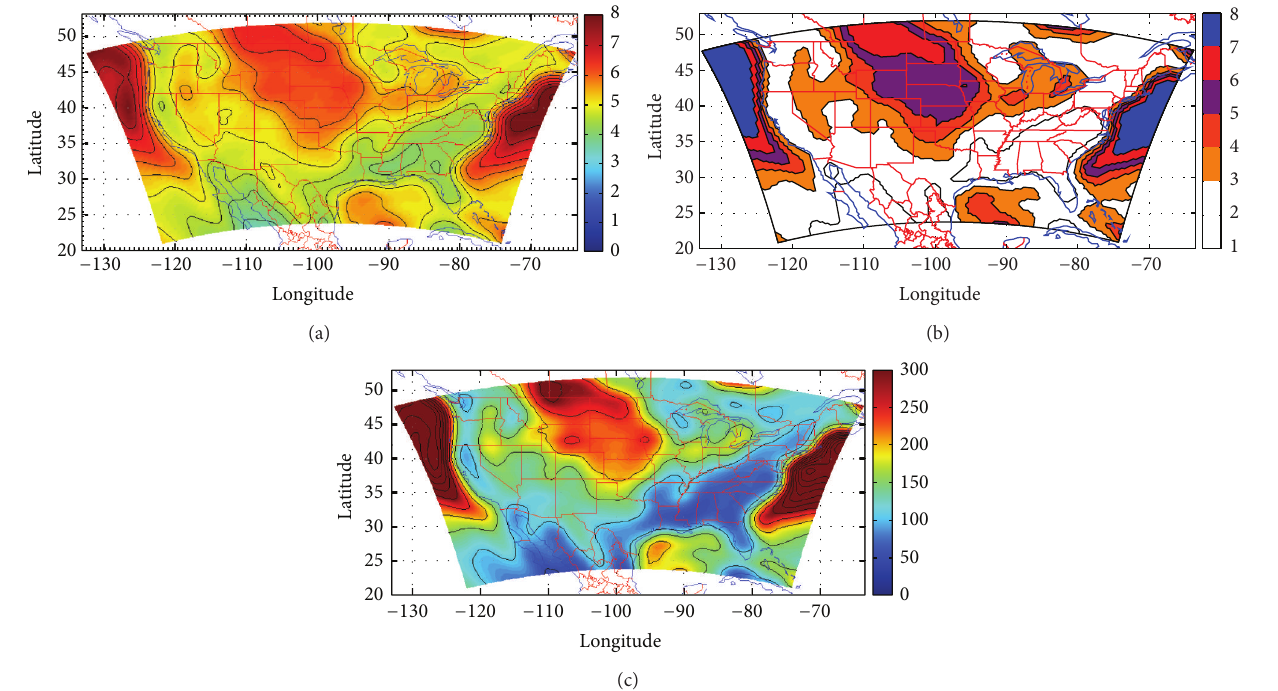
Figure 1: (a) Average annual wind speed (ms −1 ), (b) wind resource classification, and (c) average annual wind power density (Wm −2 ) based on CCSM3 data in the CONUS region for current climate